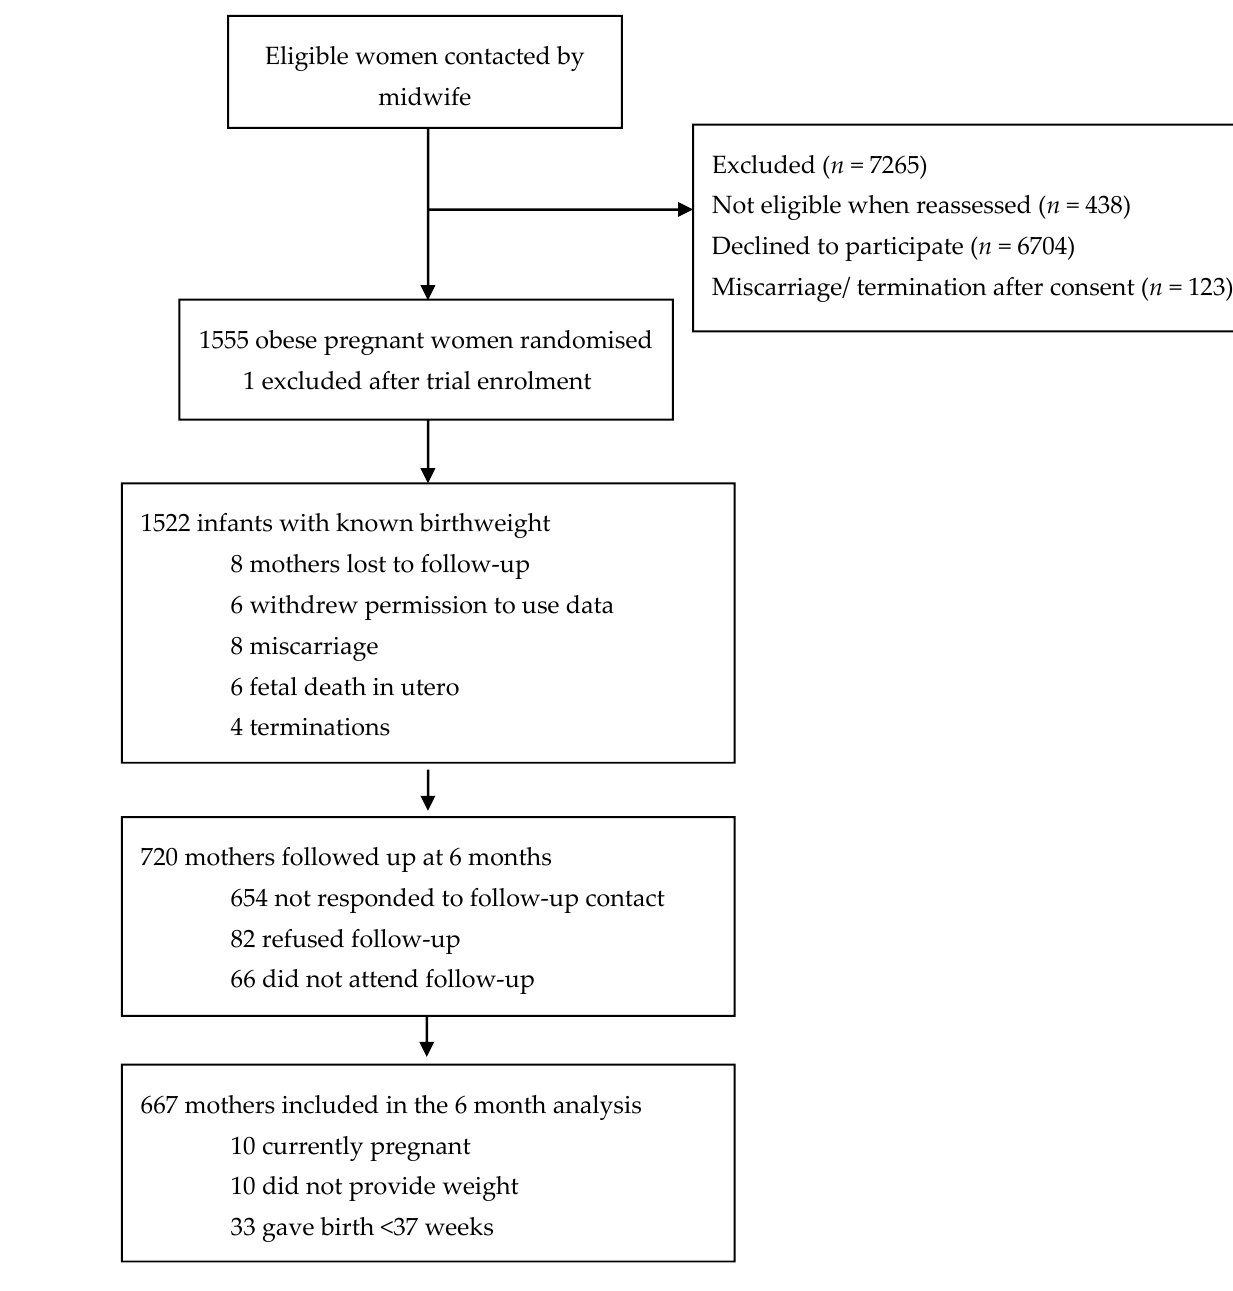
Figure 1. Consort diagram of participants enrolled in the UPBEAT trial at 6 months postpartum. Table 1. Maternal and infant demographics included in the analysis.